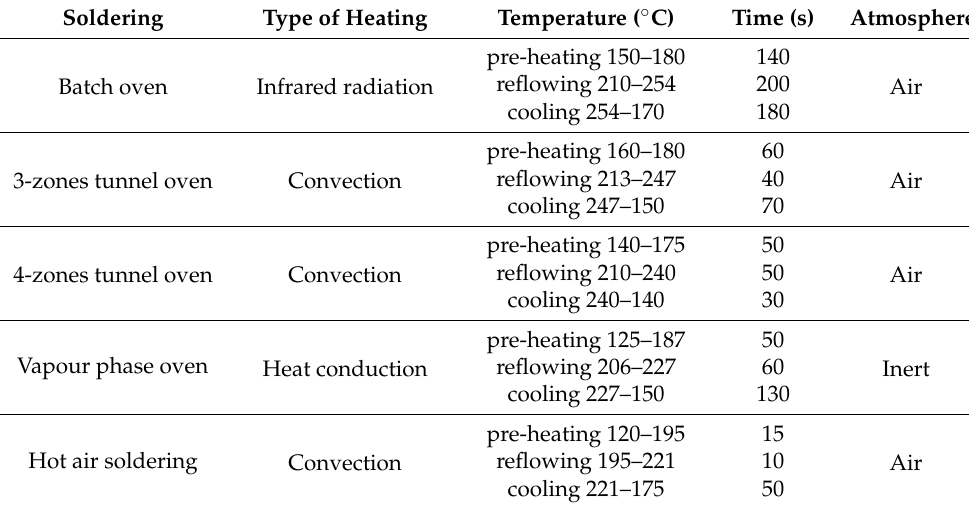
Figure 3. Soldering thermal profiles.